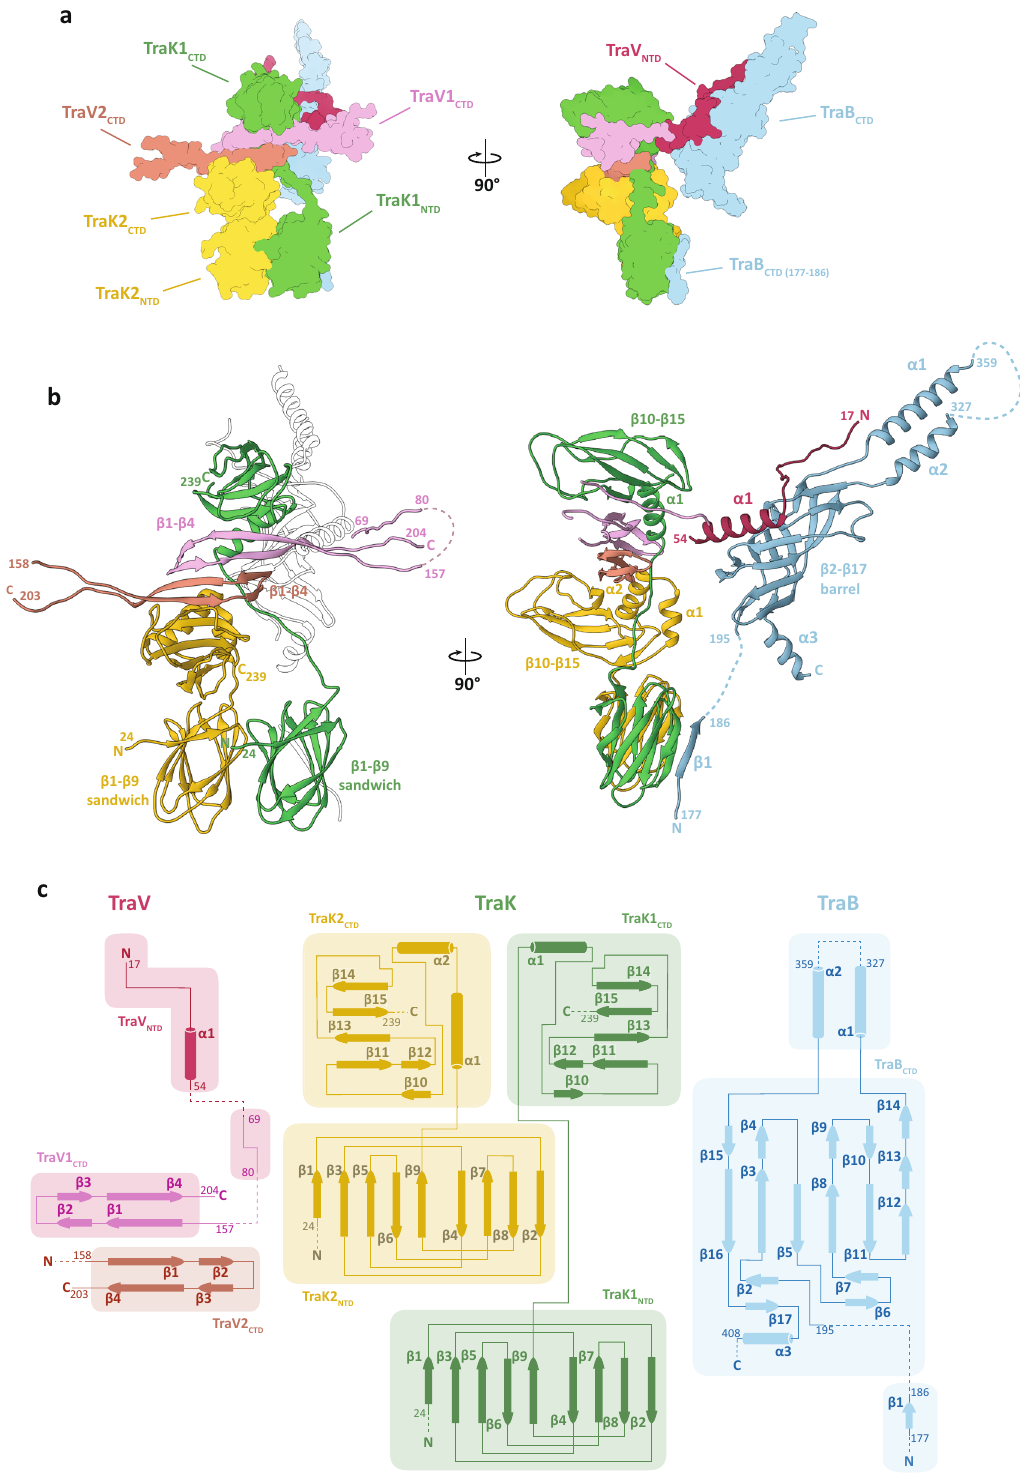
Fig. 3 The combined asymmetric units of the OMCC. a The side- and a 90° rotated view of the combined OMCC asymmetric units (ASU OR and ASU IR ) in surface representation, highlighting individual protein and protein domains. Individual proteins colour coded as described in Fig. 2a. b Cartoon representation of the combined ASU (ASU OR and ASU IR ) with same views as in ‘ a ’ , colour coded as in Fig. 2a. The individual domains and key secondary structural features along with the protein boundaries are highlighted. c Topology secondary structure diagrams of TraV (purple, pink and brown), TraK (yellow and green) and TraB (cyan). β -strands and α -helices are represented as arrows and cylinders, respectively. Regions for which no electron density was observed are indicated by dashed